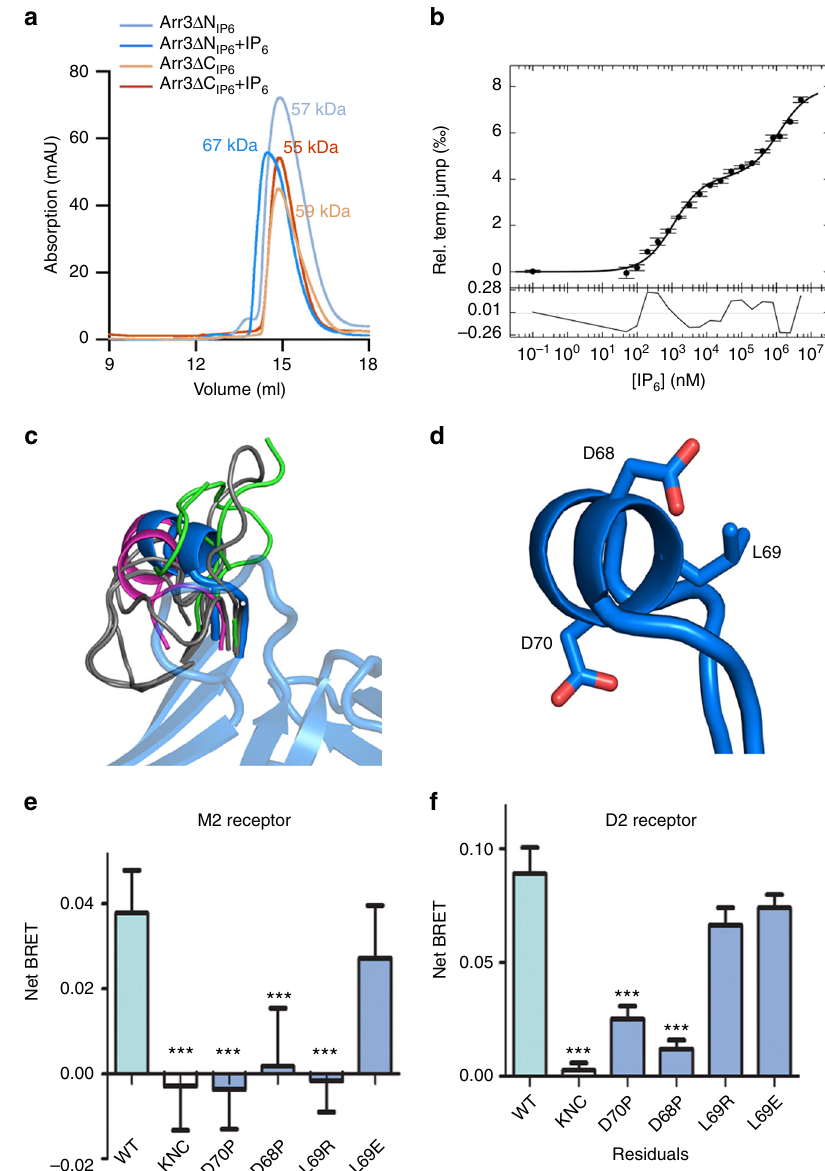
Fig. 4 The interplay between phosphate and activation sensors in receptor-independent and receptor-dependent signaling. a Size exclusion chromatography (SEC) of the Δ N IP6 and Δ C IP6 mutants measured on a Superdex S200 Increase 10/300 GL column (24 mL). Arrestin-3 (1 – 393) runs anomalously on size exclusion chromatography, but exhibits a characteristic shift in molecular weight upon the addition of IP 6 . In the absence of IP 6 , both the Δ N IP6 and the Δ C IP6 mutants are monodisperse and have a similar elution volume to wild-type, but in the presence of IP 6 , no mobility shift is observed. b Temperature-jump binding curve for the Cys-less-T222C arrestin-3. c Overlay of fi nger loop of arrestin structures. Basal (gray): PDB entries 1CF1 7 , 1JSY 35 , 1ZSH 24 , 3P2D 6 , 1G4M 4 ; active (green): PDB entries 4ZRG 12 , 4JQI 11 , 4J2Q 10 . Bound to receptor (magenta): 4ZWJ 13 . Bound to IP 6 (blue) d The conserved motif EDL/(I)D folds into an α -helix. e,f Evaluation of mean binding ± SEM of wild-type and mutant Venus-arrestin-3 binding to the luciferase- tagged e M2 muscarinic or f D2 dopamine receptor by BRET. In arrestin-3-KNC (K11A, K12A, L49A, D51A, R52A, L69A, Y239A, D241A, C252A, P253A, D260A and Q262A), two key phosphate-binding lysines and 10 residues that bind other parts of the receptor were mutated to alanines. This precludes GPCR binding as described 22, 34 , making this an appropriate negative control. Data from three experiments were compared to wild-type by one-way ANOVA. *** p ≤